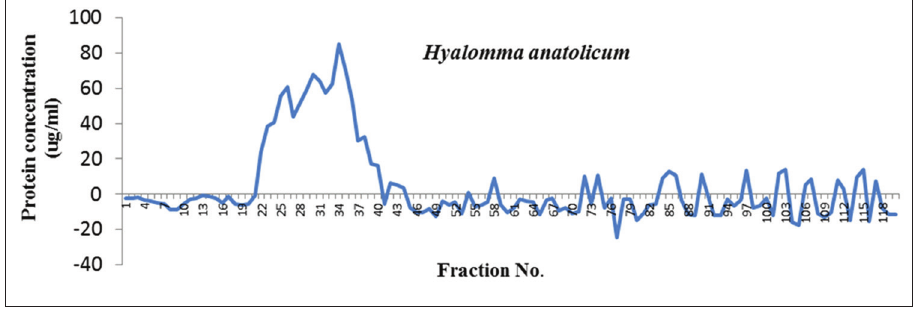
Figure-1: Total protein concentration of Hyalomma anatolicum salivary gland fractions collected by gel exclusion chromatography